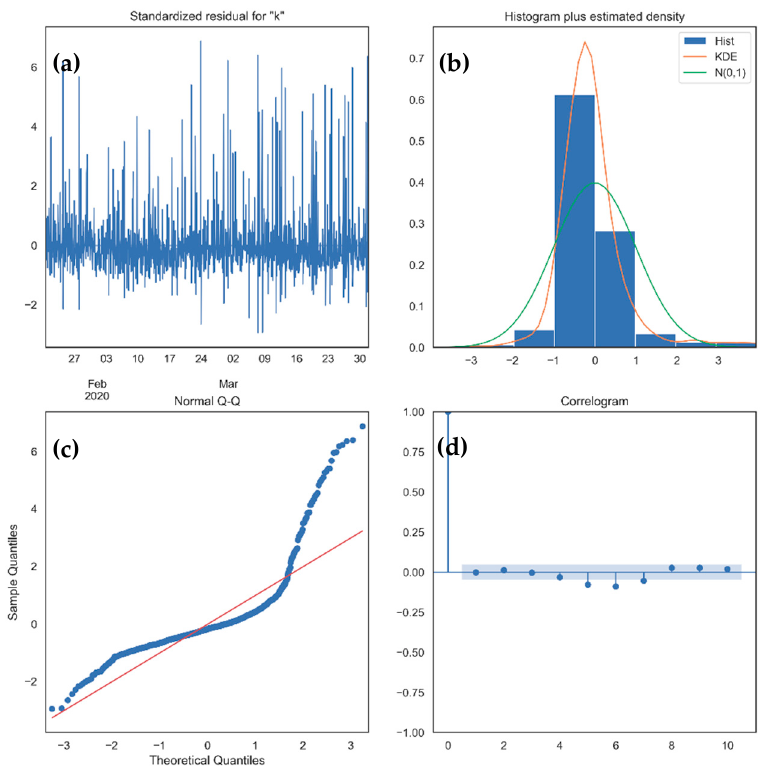
Figure A3. Testing of the SARIMA algorithm checking the best algorithm performance: ( a ) standardized residual, ( b ) histogram of the estimated density distribution, ( c ) normal probability Q ‐ Q plot, ( d ) correlagram.